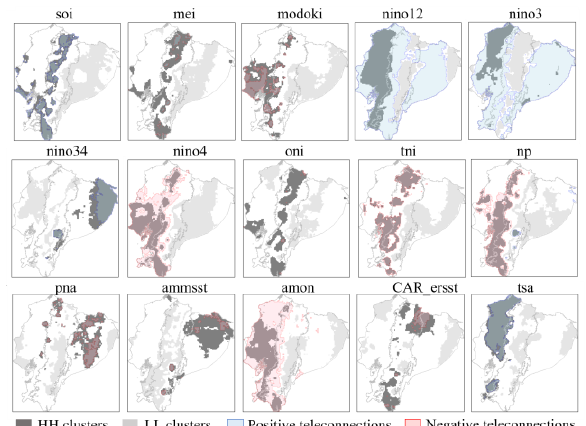
Figure 3. LISA clustered maps with significant spatial association. Dark gray areas are HH clusters, light gray areas are LL clusters, and white areas means spatial randomness. Blue polygons are moderate to high positive correlation, and the red ones are moderate to high negative correlation. Table 2. Summary of detected patterns of spatial association.